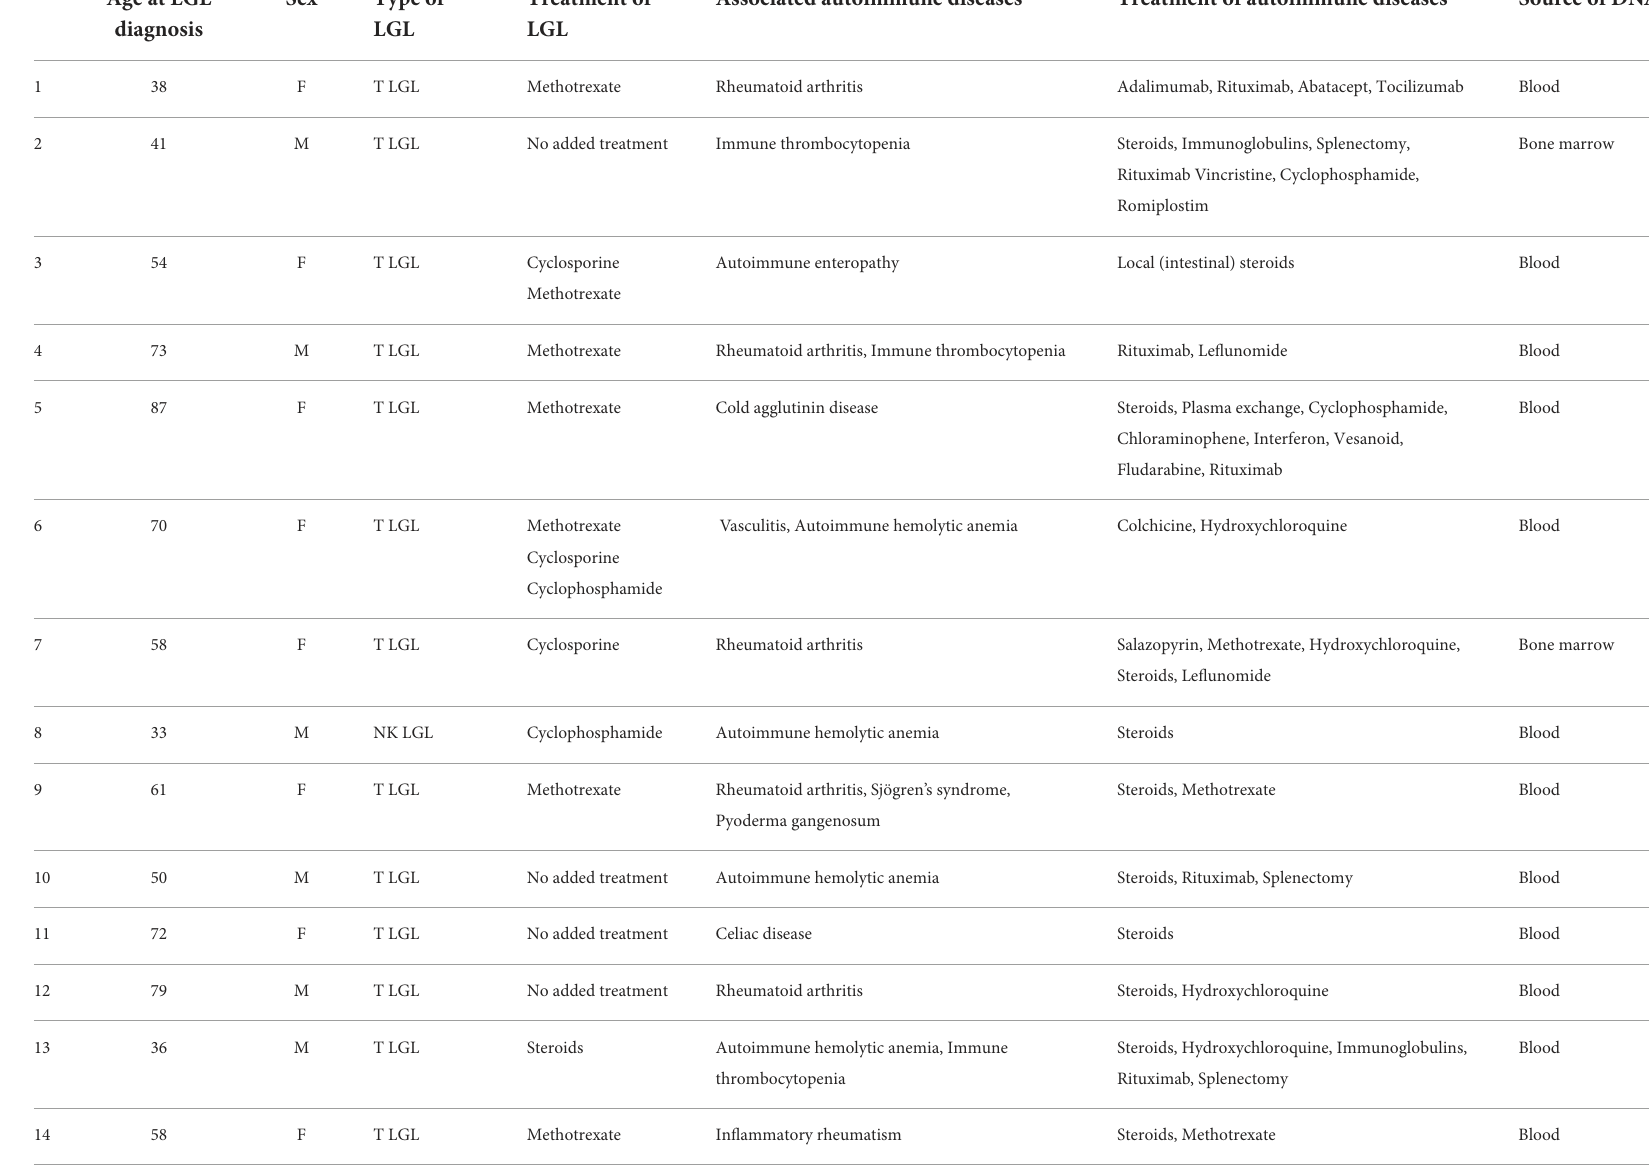
TABLE 1 Characteristics of patients with BLNK-targeted